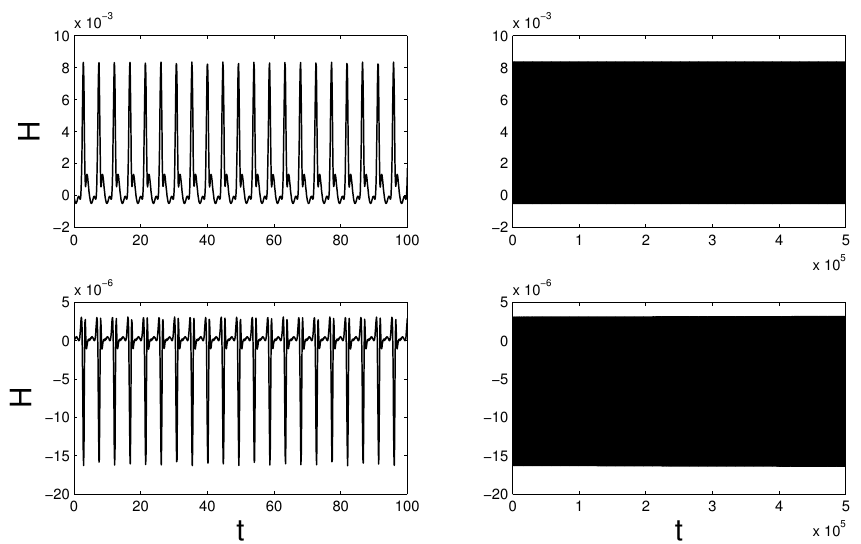
Figure 11. Hamiltonian conservation for the 1-stage ( top row ) and 3-stage ( bottom row ) Gauss methods applied to the Lotka–Volterra model with the time step h = 0.1 over the time interval [ 0,5 × 10 5 ] ( right column ), with a close-up on the initial interval [ 0,100 ] shown in ( left column ).